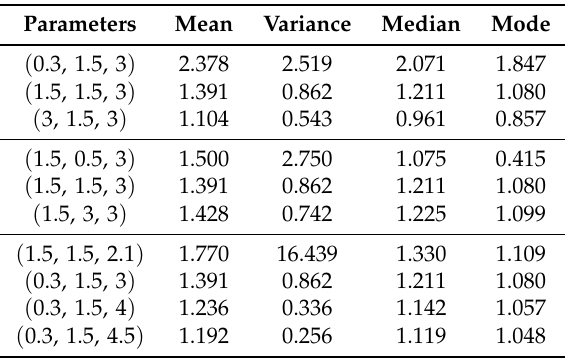
Table 3. Values of mean, variance, median and mode. Parameters Mean Variance